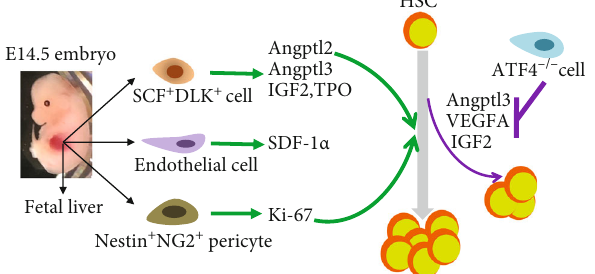
Figure 1: Microenvironment in the fetal liver is crucial for HSC proliferation. SCF + DLK + cells secret Angptl2, Angptl3, IGF2, and TPO to accelerate HSC proliferation in the fetal liver. Nestin + NG2 + pericytes associated with portal vessels is a fetal liver niche, supporting HSC expansion. Fetal liver endothelial cell produces SDF-1 α favoring HSC mobilization. Loss of ATF4 in the fetal liver niche reduces HSC expansion through decreasing Angptl3, IGF2, and